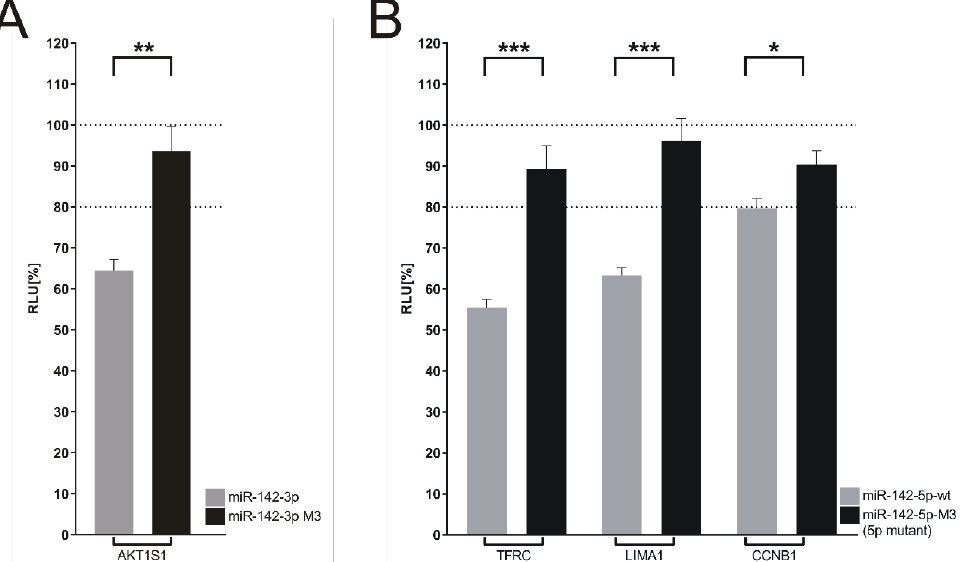
Figure 10. Confirmation of novel miR-142 targets by luciferase assay. ( A ) Analysis of AKT1S1 as a target of miR-142-3p. The 3 (cid:48) UTR of AKT1S1 was tested by dual-luciferase assay using